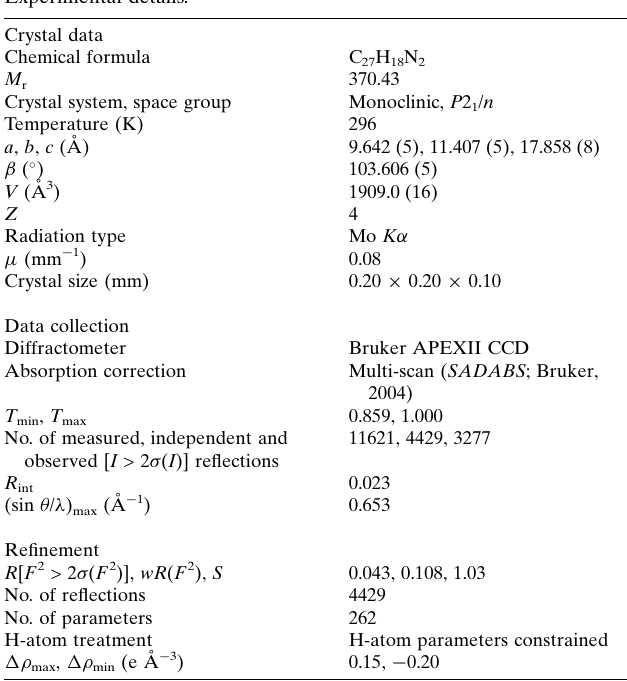
Table 2 Experimental details.